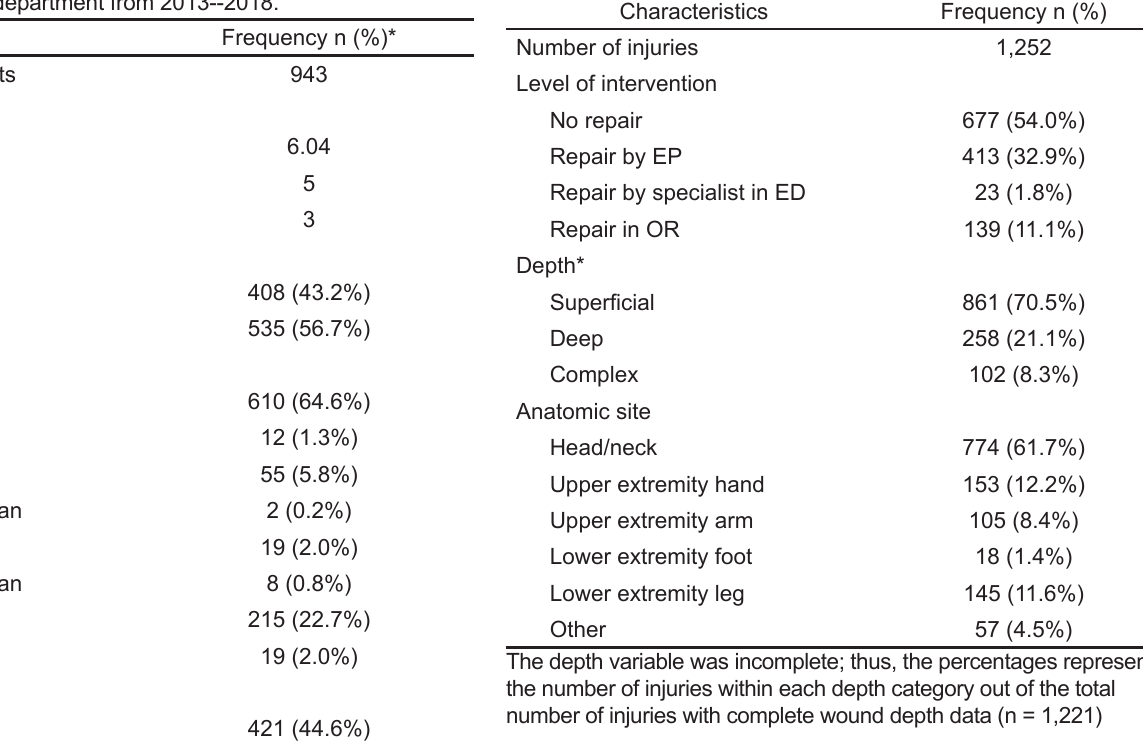
Table 1. Characteristics of pediatric dog-bite victims who presented to the emergency department from 2013--2018.